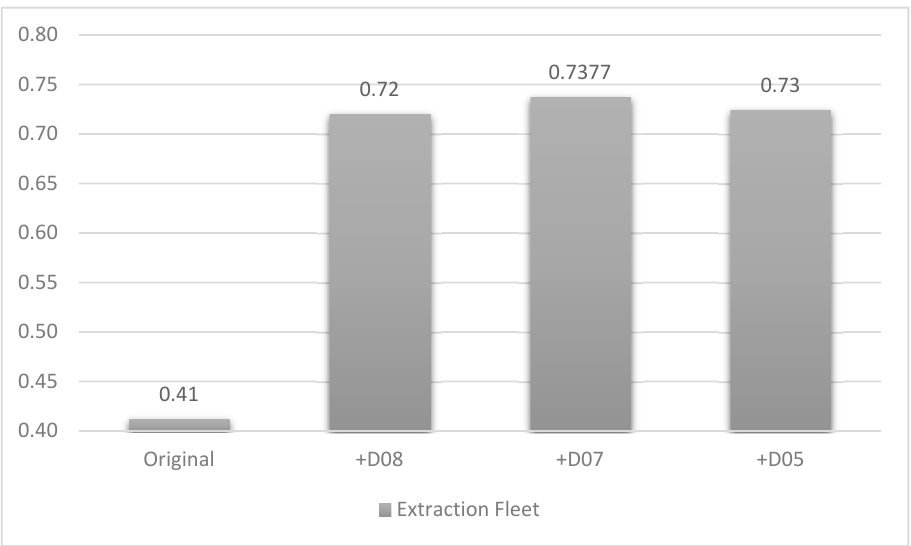
Figure 12. Systemic resilience indexes with original topology and addition of drills.